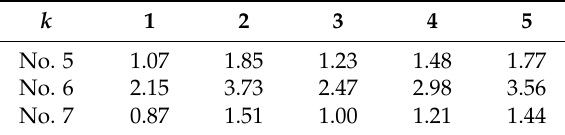
Table 3. Regeneration amplitude